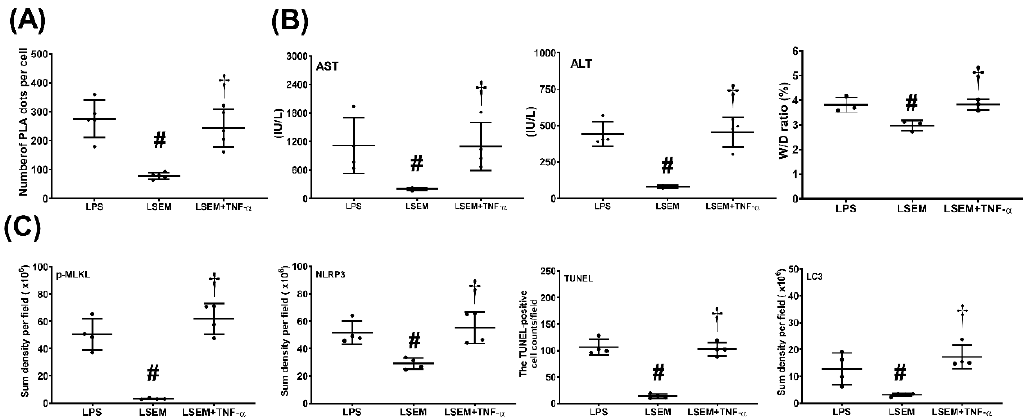
Figure7. Exogenoustumornecrosisfactor(TNF)- α counteractsthee ff ectsofSEM18peptide. ( A )Binding Figure 7. Exogenous tumor necrosis factor (TNF)-α counteracts the effects of SEM18 peptide. ( A ) of TNF- α to TNF receptor 1, as measured at 24 h after lipopolysaccharide (LPS) administration using Binding of TNF-α to TNF receptor 1, as measured at 24 h after lipopolysaccharide (LPS) immunofluorescence staining of proximity ligation assay (PLA). ( B ) Plasma concentrations of aspartate administration using immunofluorescence staining of proximity ligation assay (PLA). ( B ) Plasma aminotransferase (AST) and alanine aminotransferase (ALT) and the wet / dry (W / D) weight ratio of concentrations of aspartate aminotransferase (AST) and alanine aminotransferase (ALT) and the the liver tissues, as measured at 24 h after LPS administration. ( C ) The quantitative sum intensity of wet/dry (W/D) weight ratio of the liver tissues, as measured at 24 h after LPS administration. ( C ) The phosphorylated mixed lineage kinase domain-like pseudokinase (p-MLKL), nod-like receptor protein 3 quantitative sum intensity of phosphorylated mixed lineage kinase domain-like pseudokinase (p- (NLRP3), and microtubule-associated protein 1A / 1B-light chain 3 (LC3) in liver tissues, as measured MLKL), nod-like receptor protein 3 (NLRP3), and microtubule-associated protein 1A/1B-light chain 3 at 24 h after LPS administration using immunohistochemistry staining assay. For apoptosis analysis, (LC3) in liver tissues, as measured at 24 h after LPS administration using immunohistochemistry liver tissues were assayed using the terminal deoxynucleotidyl transferase dUTP nick-end labeling staining assay. For apoptosis analysis, liver tissues were assayed using the terminal deoxynucleotidyl (TUNEL) method and the mean TUNEL-positive cell in liver tissues (per 0.25 mm 2 ) was calculated, transferase dUTP nick-end labeling (TUNEL) method and the mean TUNEL-positive cell in liver as measured at 24 h after LPS administration. LPS: the LPS (15 mg / kg) group; LSEM: the LPS (15 mg / kg) tissues (per 0.25 mm 2 ) was calculated, as measured at 24 h after LPS administration. LPS: the LPS (15 plus SEM18 peptide group; LSEM + TNF- α : the LPS (15 mg / kg) plus SEM18 peptide and TNF- α mg/kg) group; LSEM: the LPS (15 mg/kg) plus SEM18 peptide group; LSEM + TNF-α: the LPS (15 group. Data are the mean ± standard deviation. Data of PLA, plasma ALT and AST, W / D weight mg/kg) plus SEM18 peptide and TNF-α group. Data are the mean ± standard deviation. Data of PLA, ratio, immunohistochemistry staining assay, and TUNEL assay were derived from five, four, four, four, plasma ALT and AST, W/D weight ratio, immunohistochemistry staining assay, and TUNEL assay and four mice from each group, respectively. # p < 0.05, the LSEM group vs. the LPS group; † p < 0.05, were derived from five, four, four, four, and four mice from each group, respectively. # p < 0.05, the the LSEM + TNF- α group vs. the LSEM LSEM group vs. the LPS group; † p < 0.05, the LSEM + TNF-α group vs. the LSEM group.